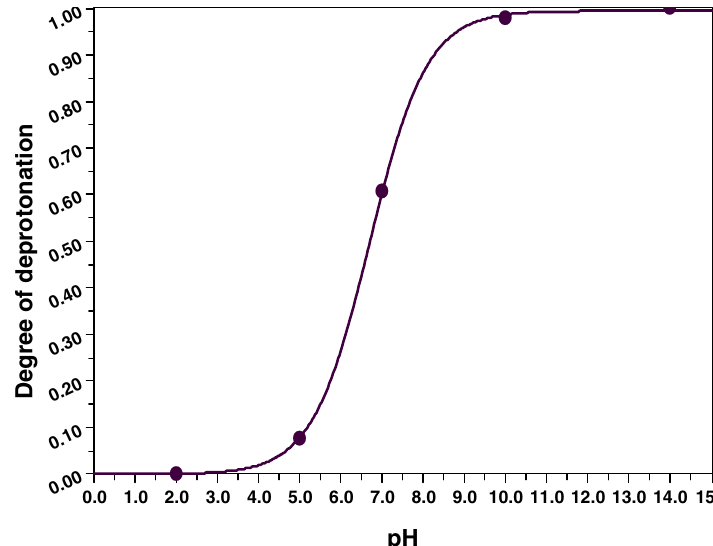
Figure 3 . The response ( α ) for an optode with a MB28 film exposed to pH